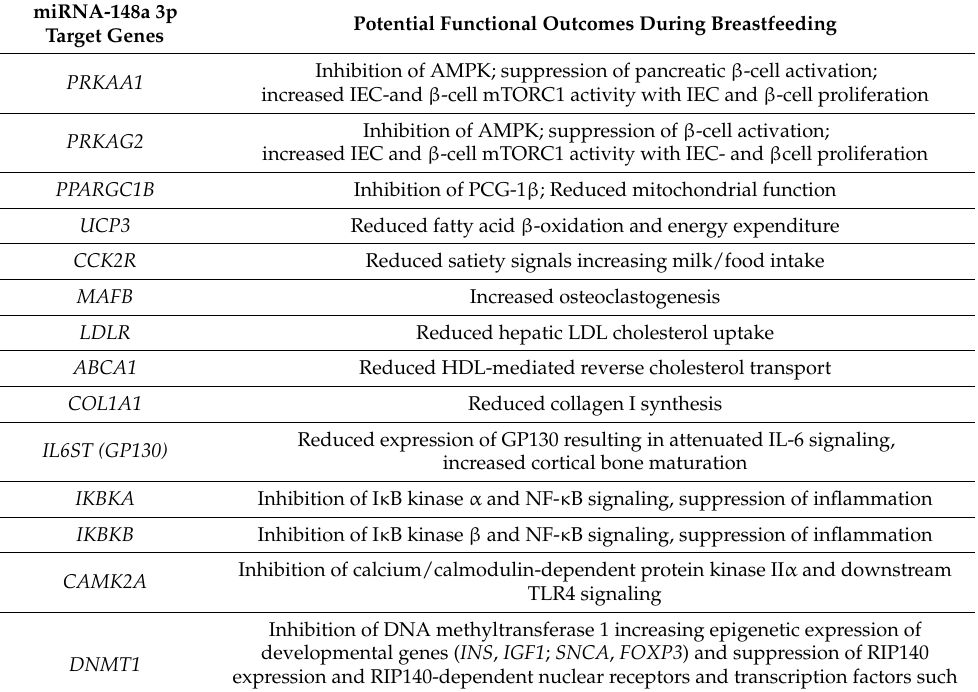
Table 2. Selected targets of MEX-derived miRNA-148a-3p and functional